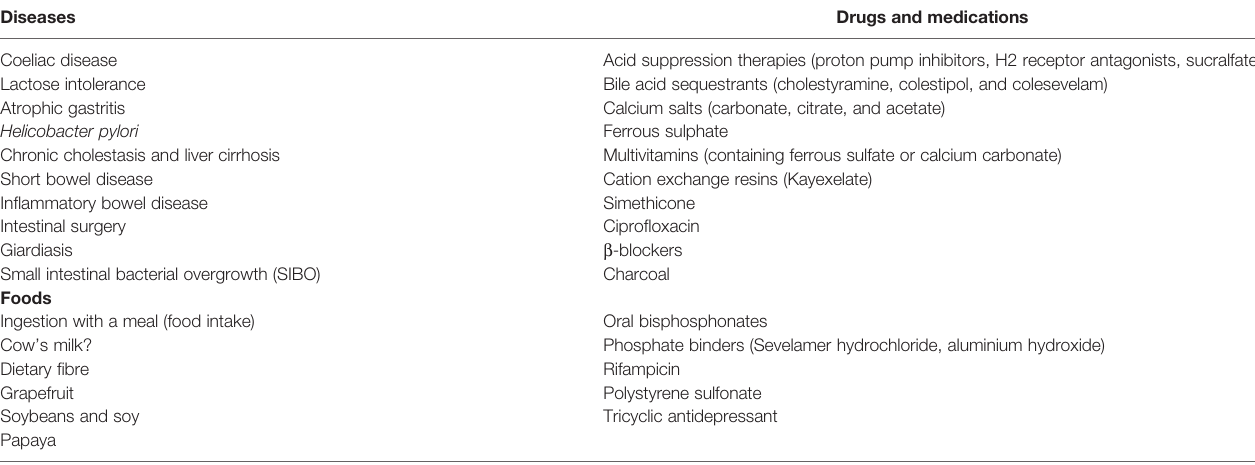
TABLE 1 | Medical conditions, drugs and medications potentially affecting l-T 4 absorption in children. Diseases Drugs and medications Coeliac